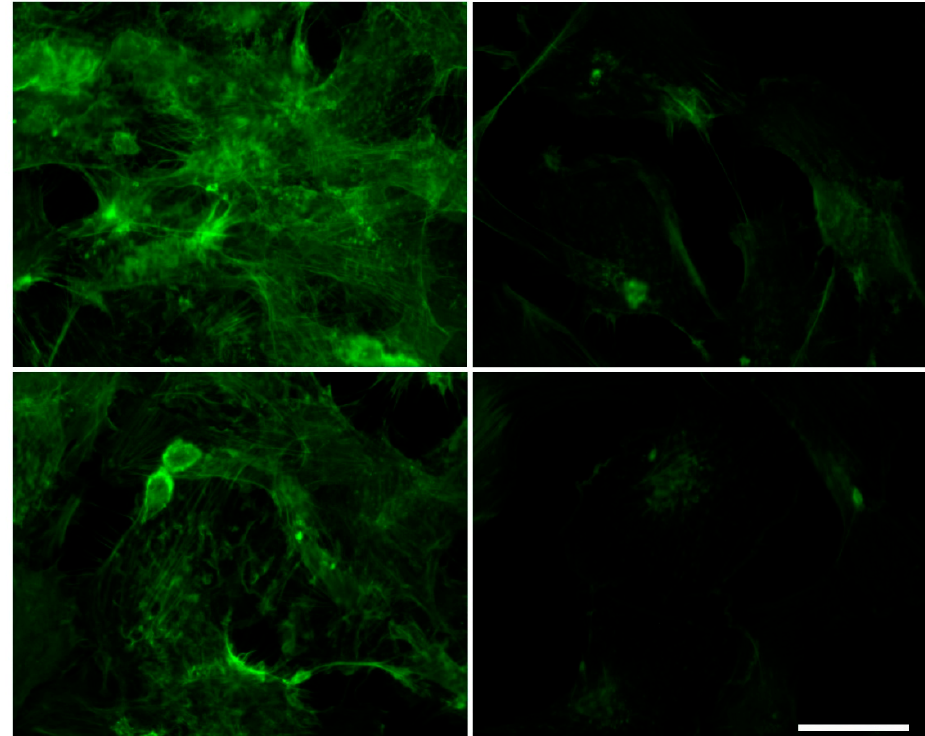
Figure 4. Effect of urea on the microfilament organization in HMEC-1. On the ( left ), control cells at 72 h. On the ( right ), cells treated with 5 g/L urea for 72 h.